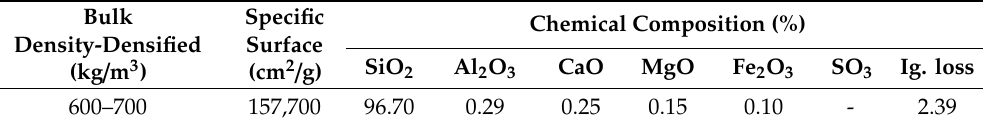
Table 4. Properties of silica fume.